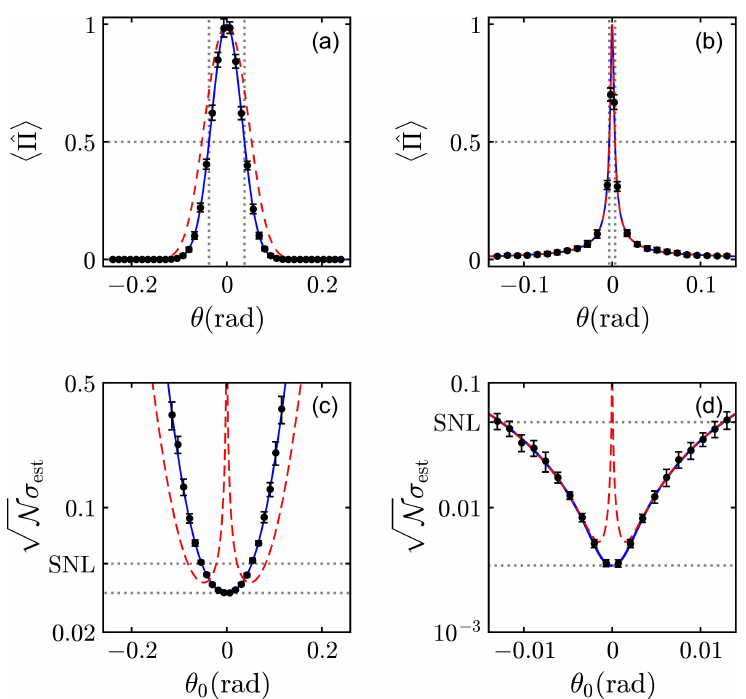
Figure 3. Numerical simulations of the signal ( a , b ) and the sensitivity ( c , d ) for ¯ n b = 0.687 ( a , c ) and ¯ n b = ¯ n /2 ( b , d ) with ¯ n = 427, using a = 0.183 ( a , c ) and a = 0.013 ( b , d ), as predicted by Equation (22). The circles and the bars: statistical average of the signal and the error per measurement (i.e., and their associated standard deviations, simulated with 20 replicas of N = 1000 random numbers at each given phase shift. Red dashed lines: the signal and the sensitivity of the binary–outcome measurement δθ bin for a = 0.5 ( a , c ) and a = 0.013 ( b , d ). Horizontal lines in ( c , d ): the upper lines √ ¯ n , and the other is given by Equation (23) and 1.11/ ( ¯ n correspond to the SNL 1/ All for the purity (cid:36) =